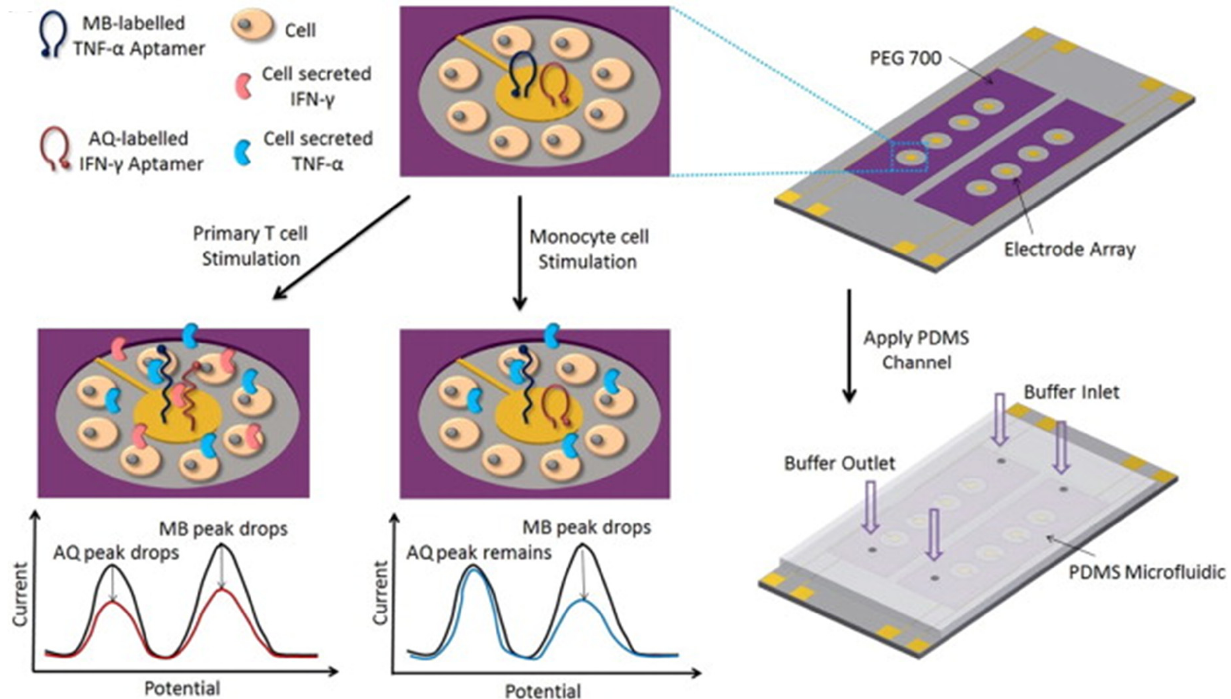
Figure 10. Schematic display of the microfluidic sensing platform using aptameric sensors for the dynamic monitoring of IFN- α and TNF- α from immune cells. Reproduced from [24] with permission.